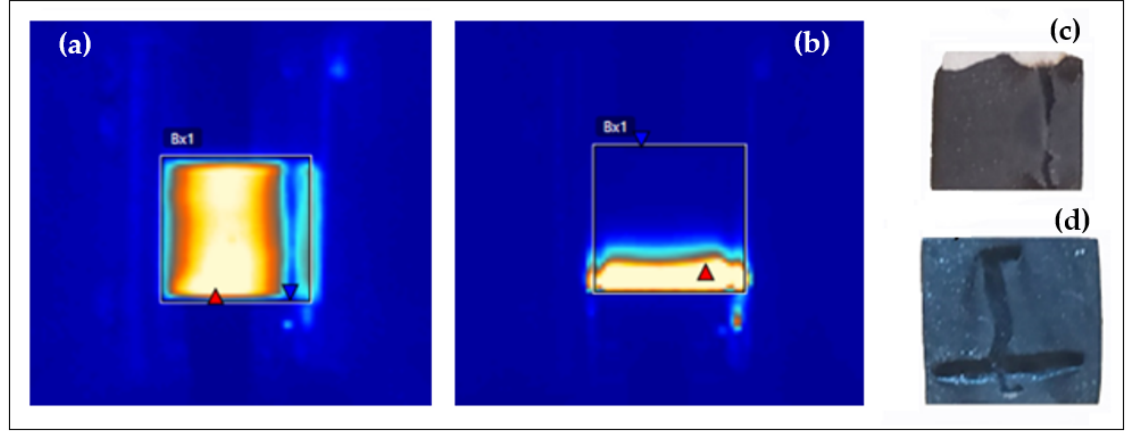
Figure 13. Thermo-photograph images of a sample without the presence of conductive paths and uniform heating ( a ), and with conductive paths and isolated heating ( b ). Photographs of the preferential conductivity paths in specimens C300 ( c ) and C750 ( d ).